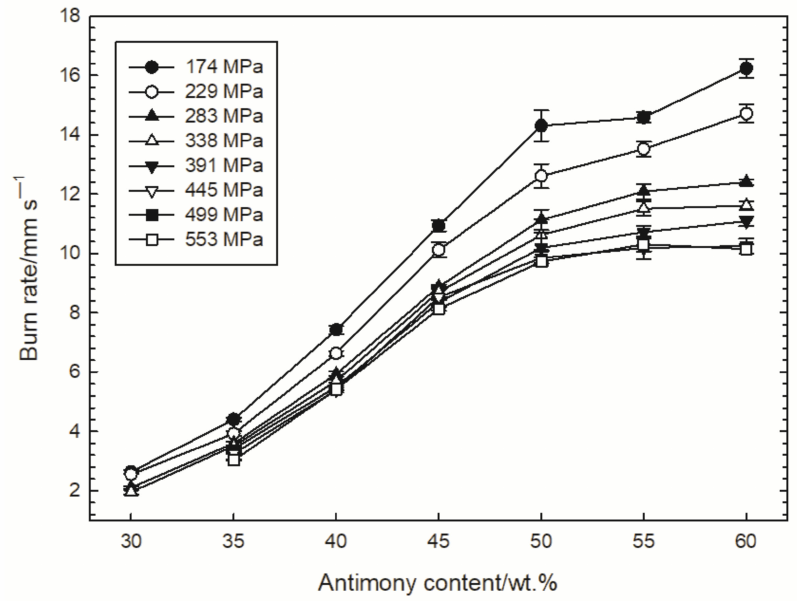
Figure 5. Influence of the loading pressure on the dependance of burn rate on antimony content.